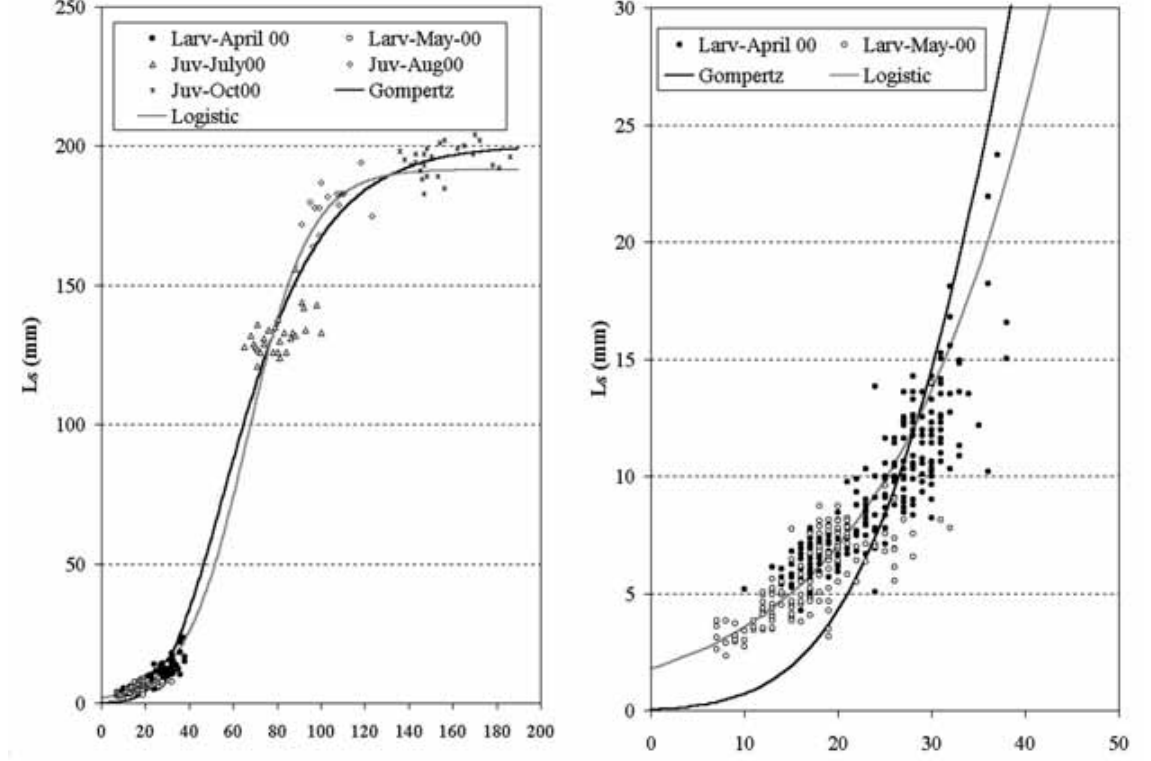
F IG . 5. – Gompertz and Logistic growth curves for larvae-postlarvae and juvenile-pre-recruits in Divisions VIIIc and IXa North in 2000. Curves not forced to pass through L = 3 mm. On the left, the full data range and on the right, only larvae data 0